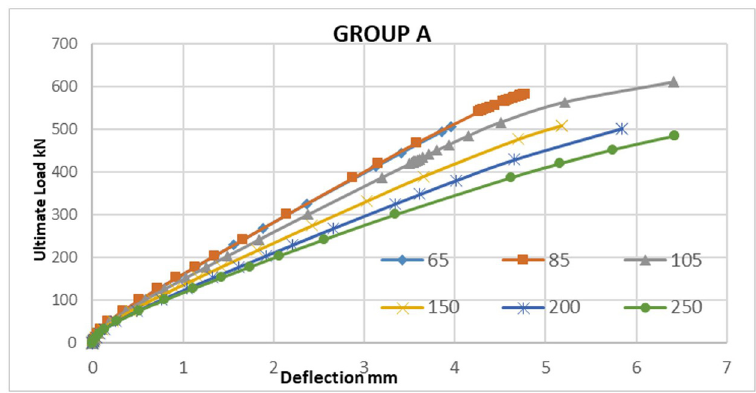
Figure 9: Load – de fl ection for the specimens of Group